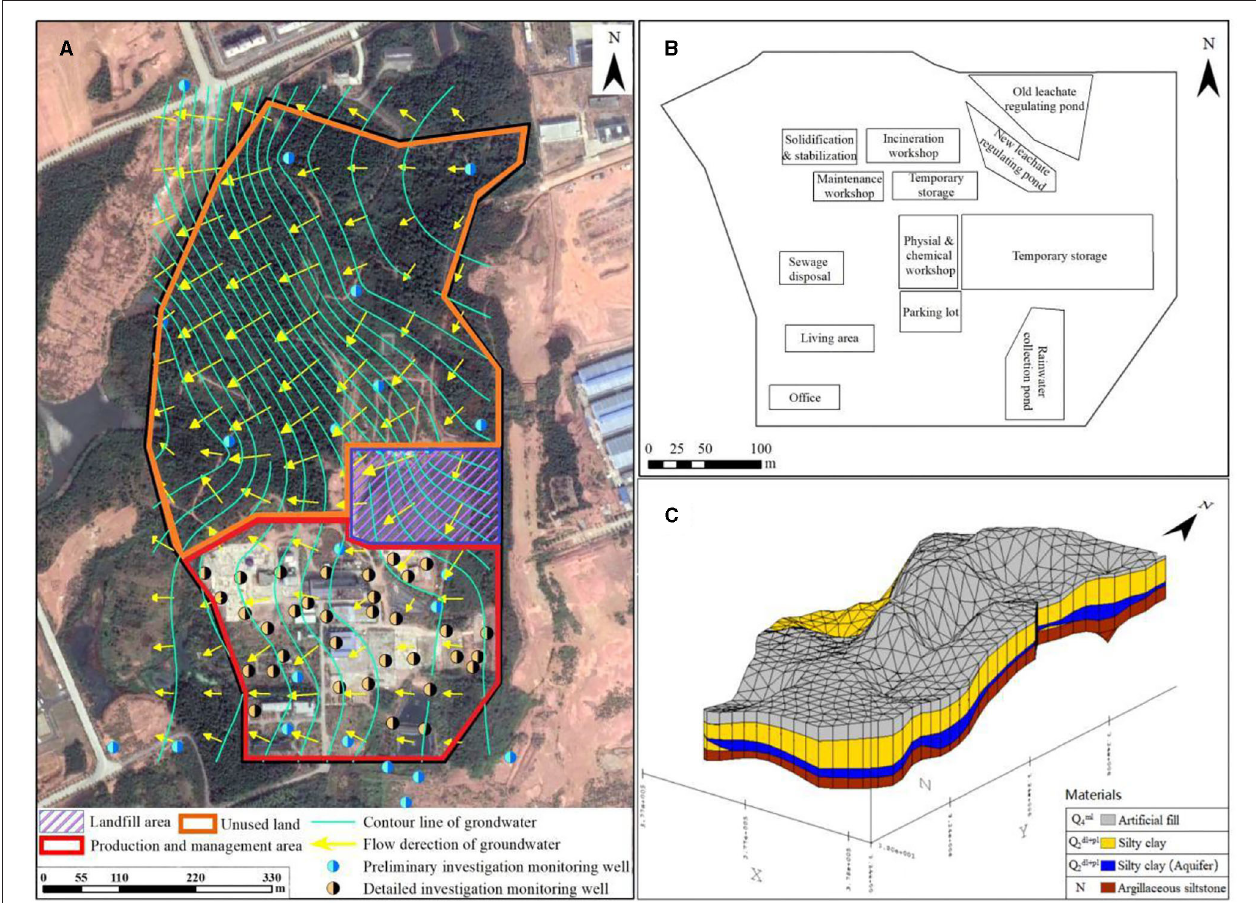
FIGURE 1 | Flow direction of groundwater (A) , production and management area (B) , and strata classifications (C)